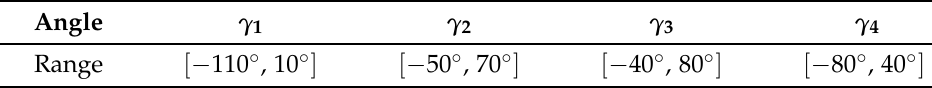
Table 6. Starting angular position for the numerical examples.